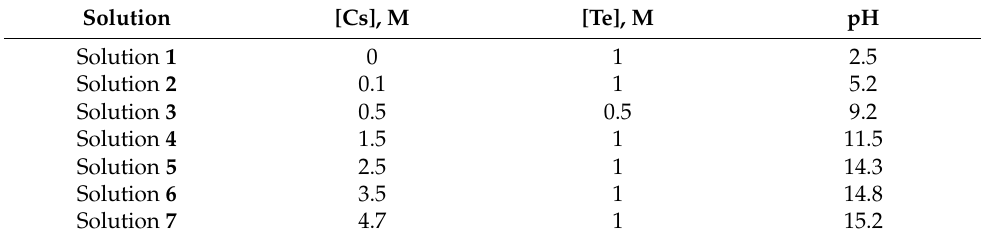
Table 1. Aqueous solutions with different pH obtained by neutralization of telluric acid with cesium